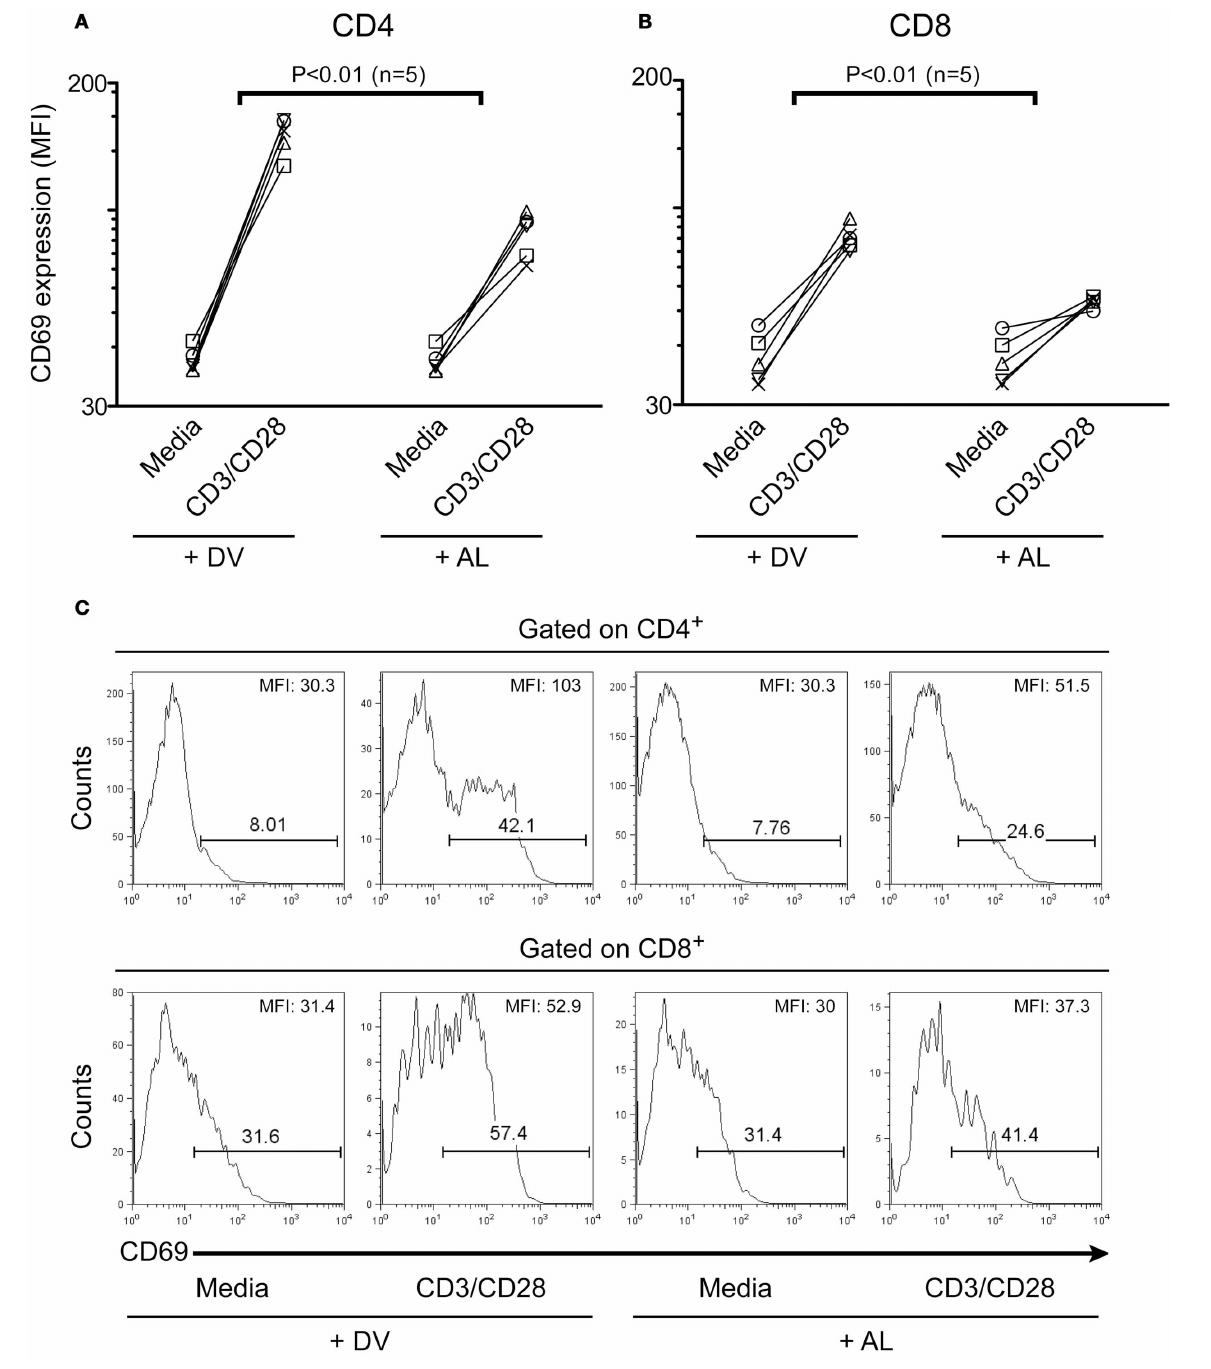
(B) T cells beforeand following stimulation with anti-CD3/CD28antibodies,in thepresenceof drug vehicle ( + DV)or allopurinol( + AL), for each subject evaluated.Comparisonsbetweenthedifferencesin net CD69 expression(subtractingCD69 MFIin media) with and without allopurinolwere performedby Wilcoxon signedrank test. Representativehistogram plots of CD69expressionon CD4 + ( C , toppanels) and CD8 + ( C , bottompanels) T cells with the indicated treatment.Thenumbersover the barsindicate the percentagesof CD69 + cells and the numbersin the top right corner indicate theMFI of CD69expressionon CD4 + (top)and CD8 + (bottom)T